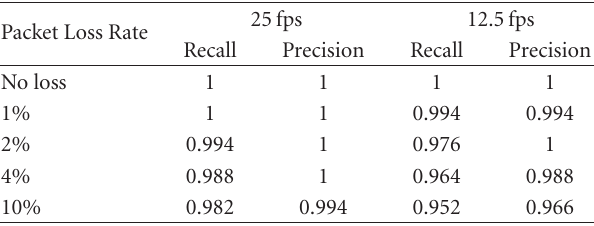
Table 3: Recall and Precision average performance of the detector, for the same video sequence at 25 and 12.5 fps, and di ff erent packet loss